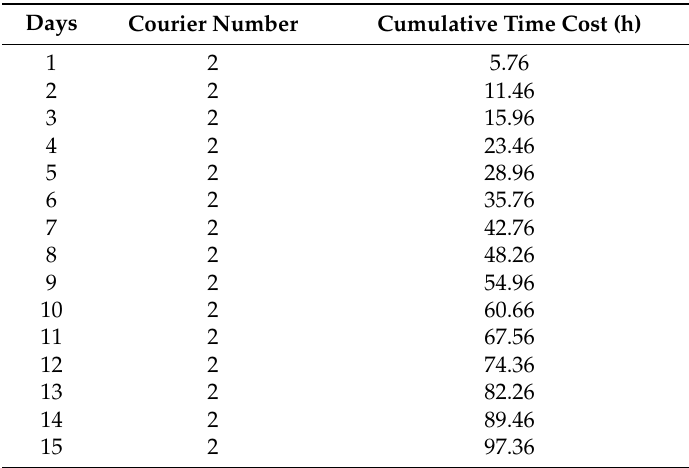
Table 4. Courier 2 cumulative time cost.